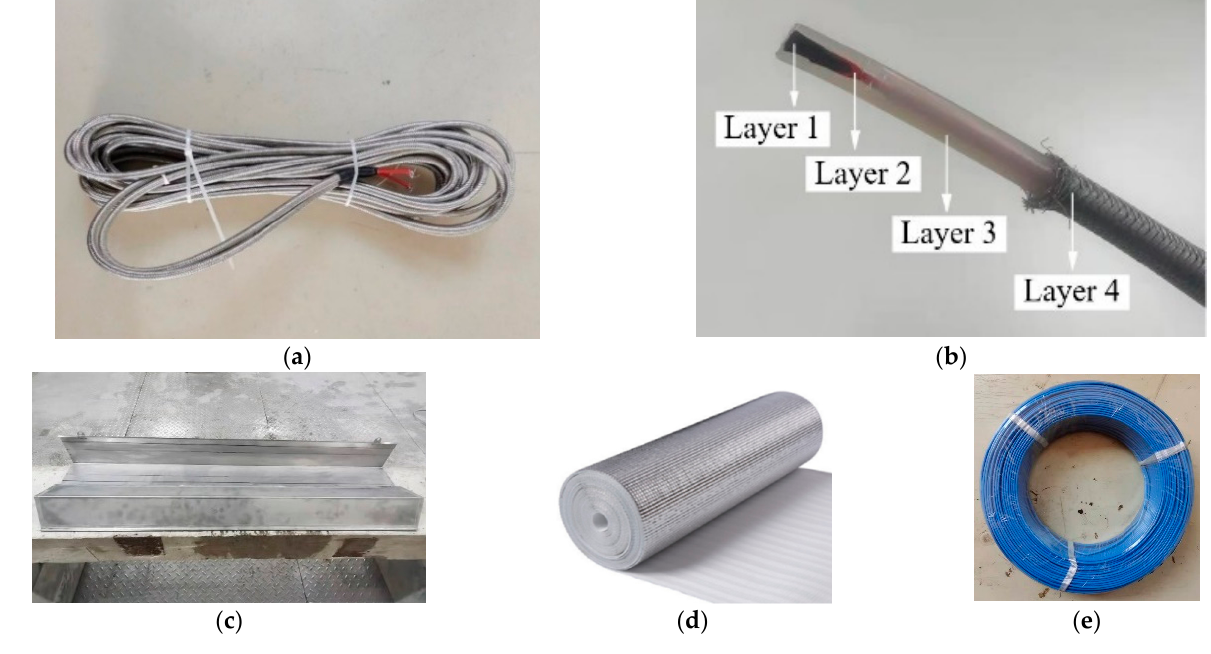
Figure 7. ( a ) Overall view of a single CFHC; ( b ) the sectional diagram of the CFHC; ( c ) stainless steel sheet; ( d ) heat-insulating film; ( e ) thermocouple wires. Table 1. Performance parameters of the CFHC.